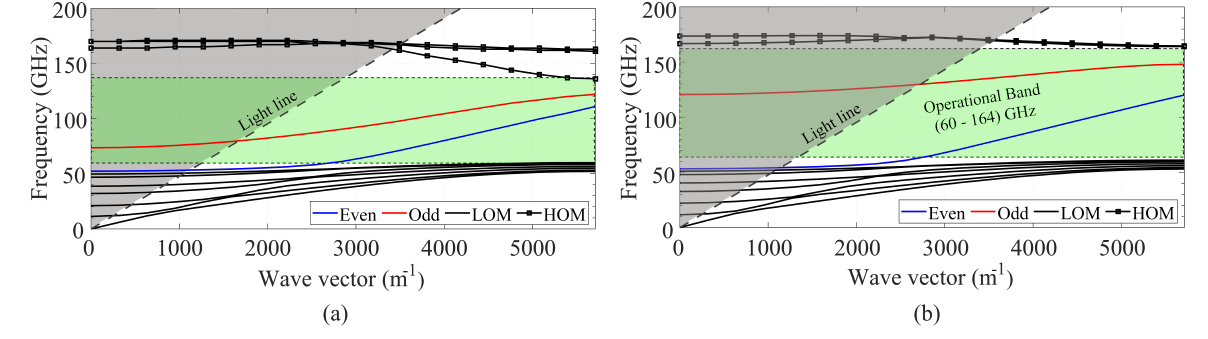
Figure 9. IGCPW dispersion diagrams for varying channel dimensions. ( a ) w c = 450 µ m, h c = 150 µ m. ( b ) w c = 350 µ m, h c = 50 µ